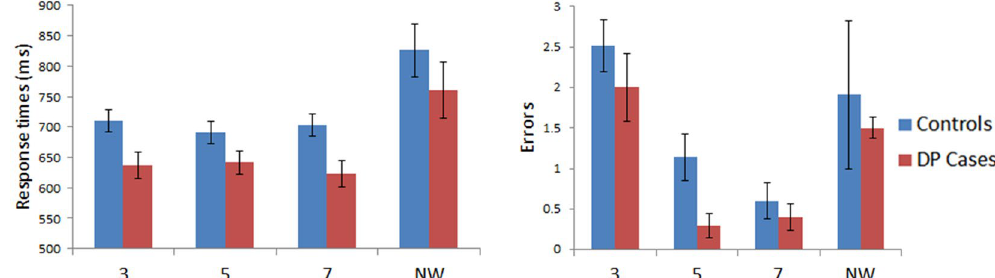
Figure 2. Results for Lexical Decision: Length (word confusability not controlled). Data for words and non- words (NW) are shown in left panel (response time) and right panel (number of errors) for control and DP groups. Error bars indicate ± SEM. The three word conditions are words comprised of 3-, 5-, or 7-letters. As there were 3 times more items in the NW condition, the NW errors were divided by 3 to make their rates displayed in the graph proportionally comparable to the word conditions.